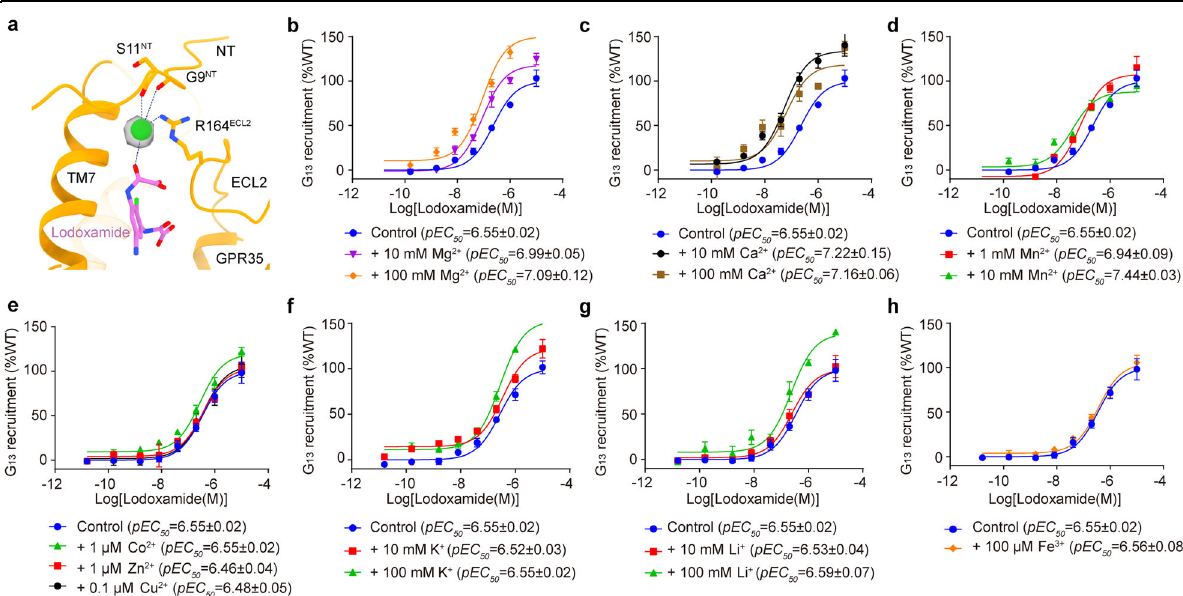
Fig. 2 Allosteric agonism of GPR35 by cations. a Architecture of the cation coordination site. The cation is coordinated by the backbone oxygen of G9 NT and S11 NT , the side chain of R164 ECL2 , and a carbonyl oxygen atom of lodoxamide. Cation in GPR35 is displayed as a green sphere, while its EM density is colored in grey. Interactions between the cation and surrounding residue coordinates are indicated as blue dashed lines. b – h Allosteric regulatory effects of different cations on lodoxamide-induced G 13 recruitment by GPR35, including Mg 2 + ( b ), Ca 2 + ( c ), Mn 2 + ( d ), Co 2 + , Zn 2 + , Cu 2 + ( e ), K + ( f ), Li + ( g ), and Fe 3 + ( h ). The concentrations of different cations are indicated. The physiological concentrations of Co 2 + , Zn 2 + , Cu 2 + , and Fe 3 + are much lower than those of Mg 2 + and Ca 2 + (WHO Vitamin and Mineral Nutrition Information System, VMNIS). The maximum cell safety concentrations of these cations under our experimental conditions were